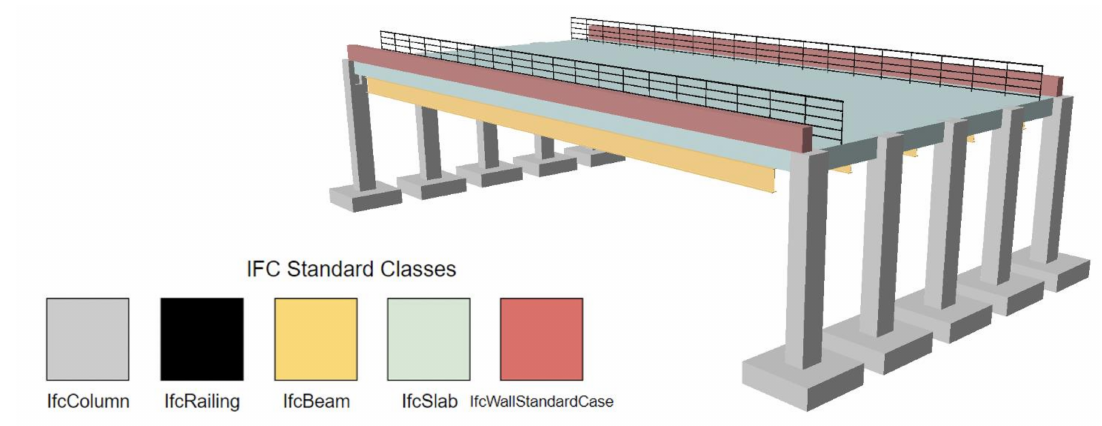
Figure 5. Standard IFC classes assigned to Revit